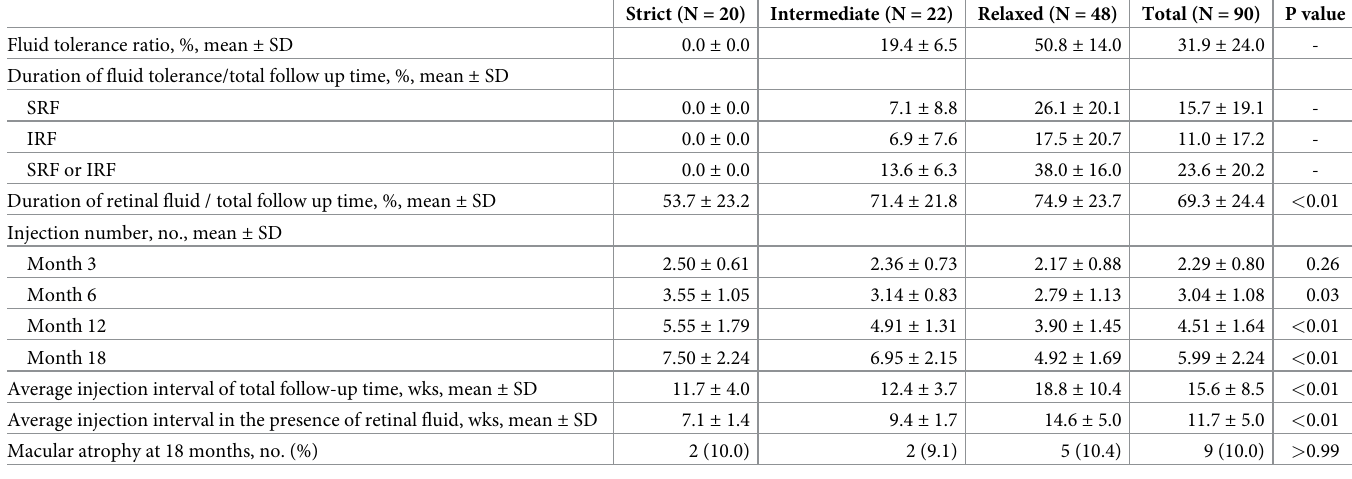
Table 3. Fluid tolerance and injection intervals among strict, intermediate, and relaxed